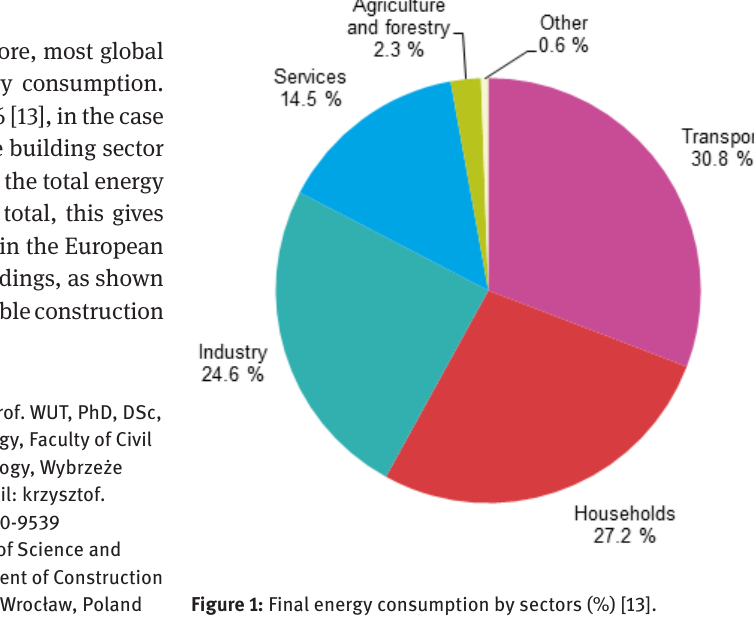
Figure 1: Final energy consumption by sectors (%)